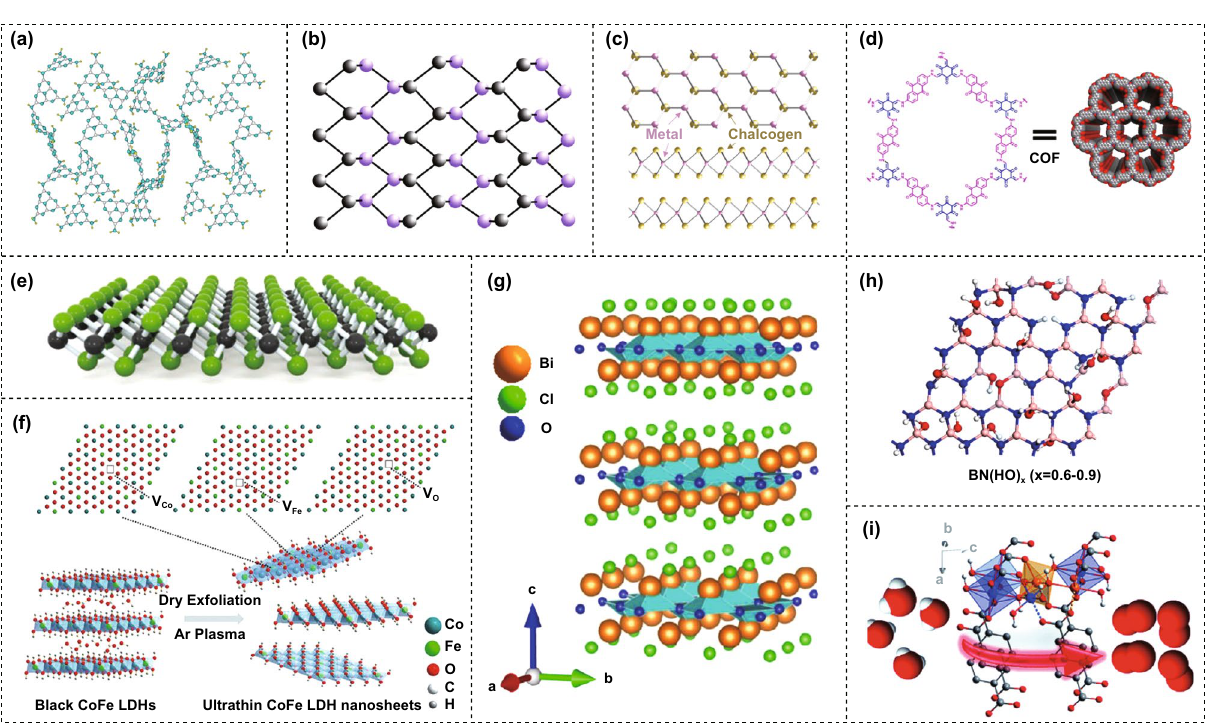
Fig. 4 Example 2D nanomaterial structures. a Graphene and graphitic carbon nitride. Reproduced with permission [260]. Copyright 2015, Wiley–VCH. b Family of mono-elemental compounds. Reproduced with permission [263]. Copyright 2018, Springer Nature. c TMD. Repro- duced with permission [264]. Copyright 2017, American Chemical Society. d COF. Reproduced with permission [189]. Copyright 2020, IOP Publishing Ltd. e MXene. Reproduced with permission [191]. Copyright 2017, Wiley–VCH. f LDHs. Reproduced with permission [271]. Copy- right 2017, Wiley–VCH. g BiOX. Reproduced with permission [275]. Copyright 2020, American Chemical Society. h h-BN. Reproduced with permission [276]. Copyright 2014, American Chemical Society. i MOF. Reproduced with permission [277]. Copyright 2020, Royal Society